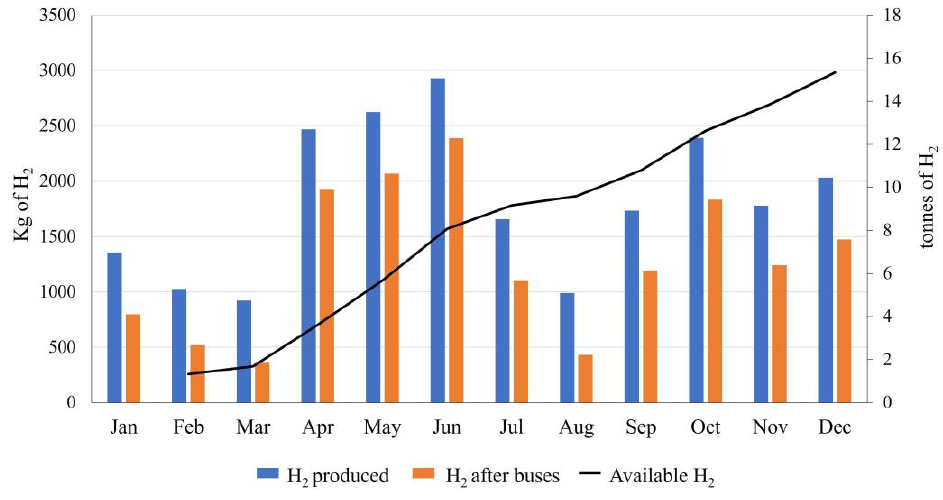
Figure 8. Simulated produced hydrogen along with the net quantities after fueling the buses.